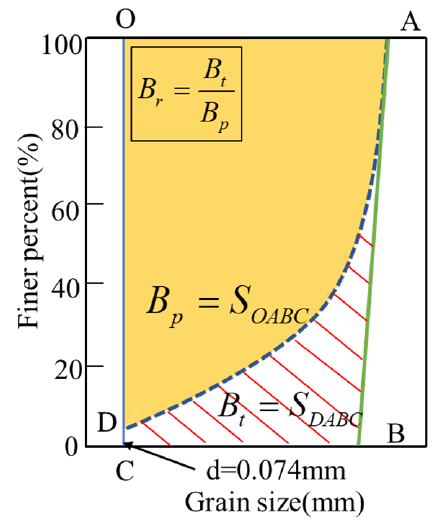
Figure 14. Defining of the relative breakage rate.